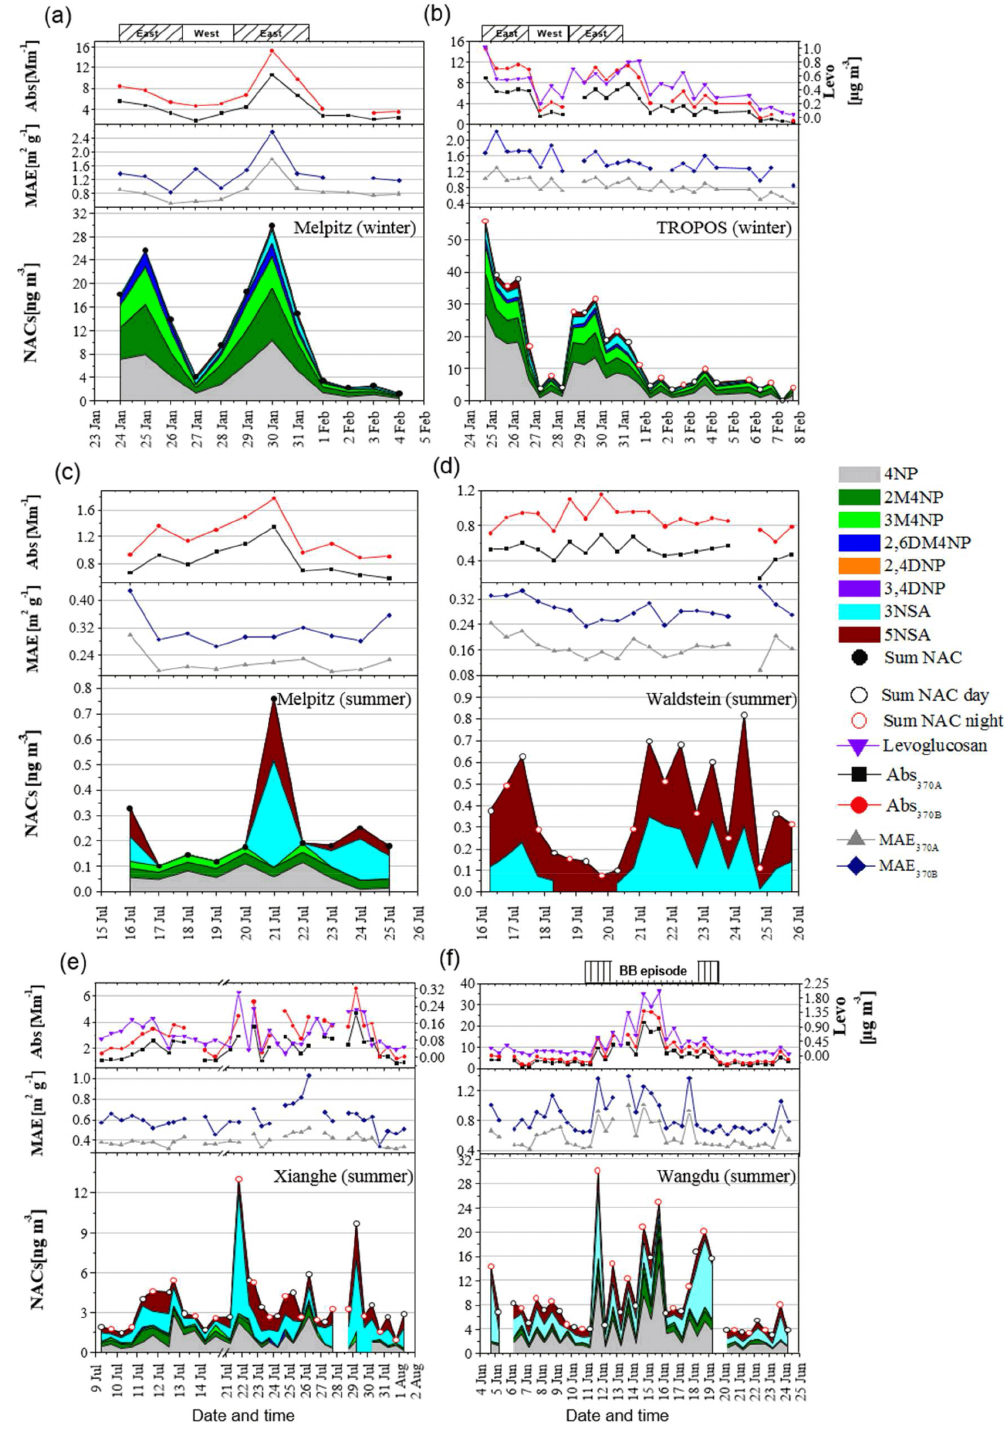
Figure 1. Temporal variation of the concentrations of nitrated aromatic compounds and levoglucosan (Levo) at each measurement site (a–f) and their optical properties. The aqueous light absorption coefficient (Abs) and mass absorption efficiency (MAE) are given at 370nm for acidic conditions (indicated by the subscript “A”) and for alkaline conditions (indicated by the subscript